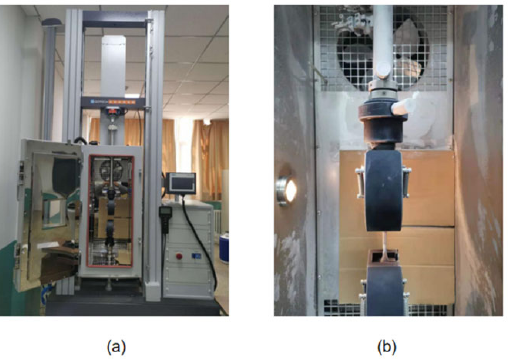
Figure 2. ( a ) Experimental machine. ( b ) Temperature control box.